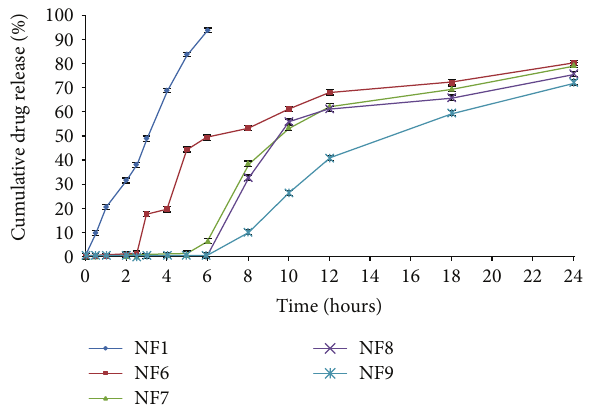
Figure 5: Comparison of in vitro release profiles of naproxen sodium core tablets (NF1), press-coated Eudragit RSPO:RLPO formulation (NF6), and press-coated Eudragit RSPO: RLPO tablets enteric coated with Eudragit S-100 in different concentrations of 2.5%, 5.0%, and 7.5% (NF7, NF8, and NF9), respectively. Data are expressed as mean ± S.D. ( 𝑛 = 3 ).